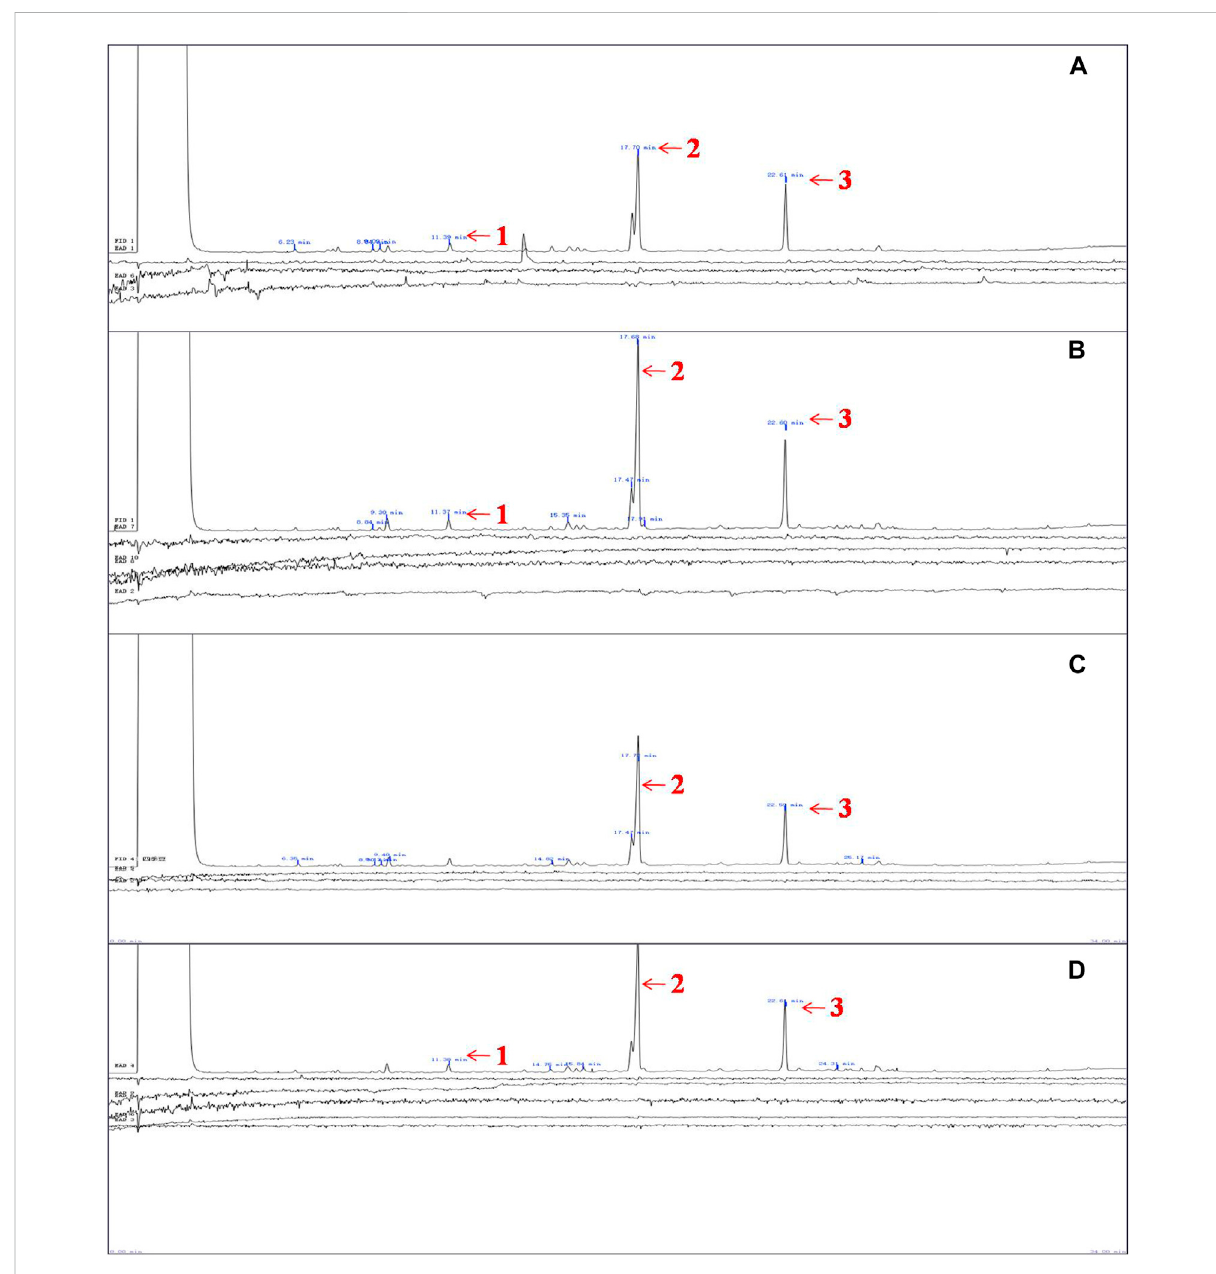
FIGURE 2 Measured EAG responses of A. lucorum and A. suturalis to volatiles from Phaseolus vulgaris . (A) The EAG responses of female A. lucorum to volatiles from P. vulgaris , (B) The EAG responses of female A. suturalis to volatiles from P. vulgaris , (C) The EAG responses of male A. lucorum to volatiles from P. vulgaris , (D) The EAG responses of male A. suturalis to volatiles from P. vulgaris 1, 2,3 indicated FID peaks of three volatiles at 11.39 min, 17.70 min, and 22.61 min, approximately, which induced EAG responses of (A) lucorum and A. suturalis